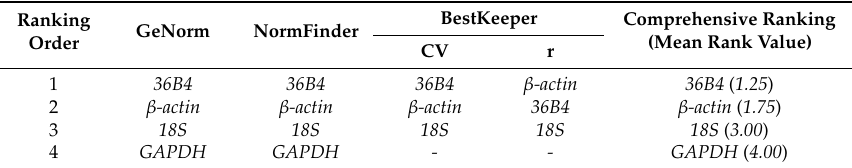
Table 5. Comprehensive ranking (iBeAT).